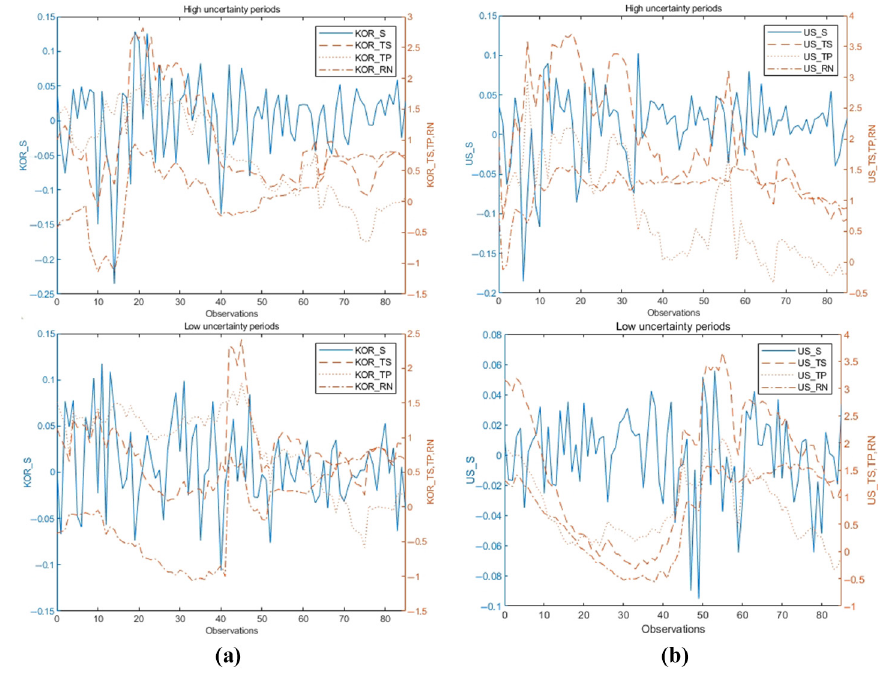
Figure 1. Time-series of stock market returns, term spread and its components with uncertainty in Korea and the